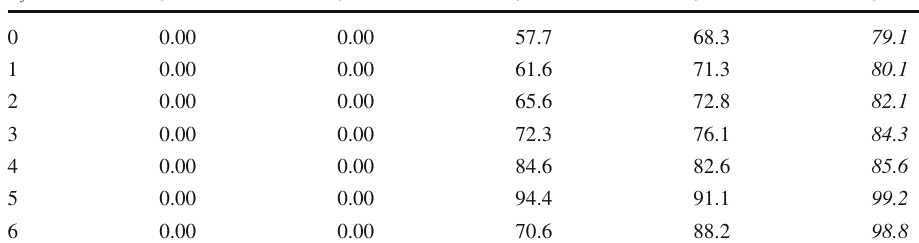
Table 4 The relative weight ( 1 + | d /δ | ) − 1 × 100% j j